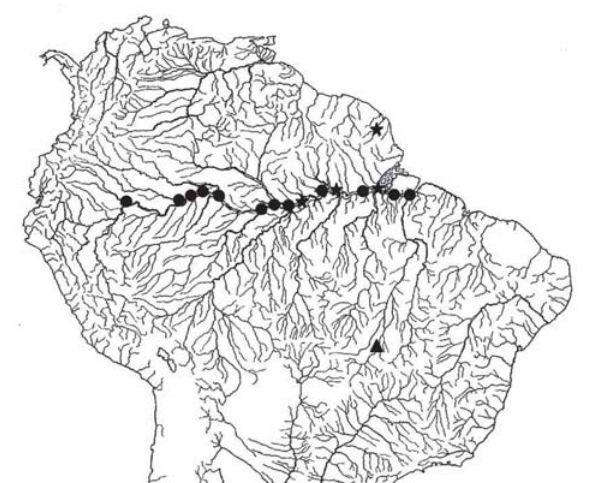
Fig. 4. Partial map of South America showing the distribution localities for Propimelodus araguayae (black triangle), P. eigenmanni (black stars) and P. caesius (black circles). Each symbol may represent more than one locality or lot. Localities of P. caesius and P. eigenmanni from Parisi et al ., 2006 and Lundberg & Parisi, 2002, respectively.